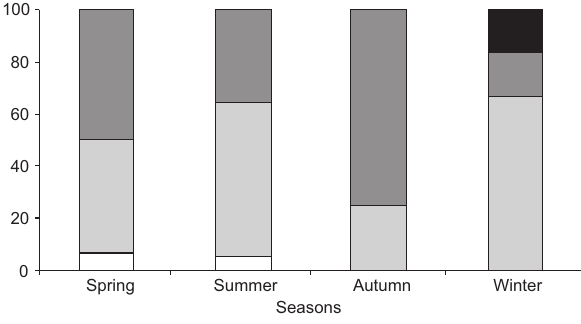
Figure 4. Use of microhabitat by active C. vacariensis during the seasons in the study area, municipality of Bom Jesus between Oc- tober 2006 and September 2007.